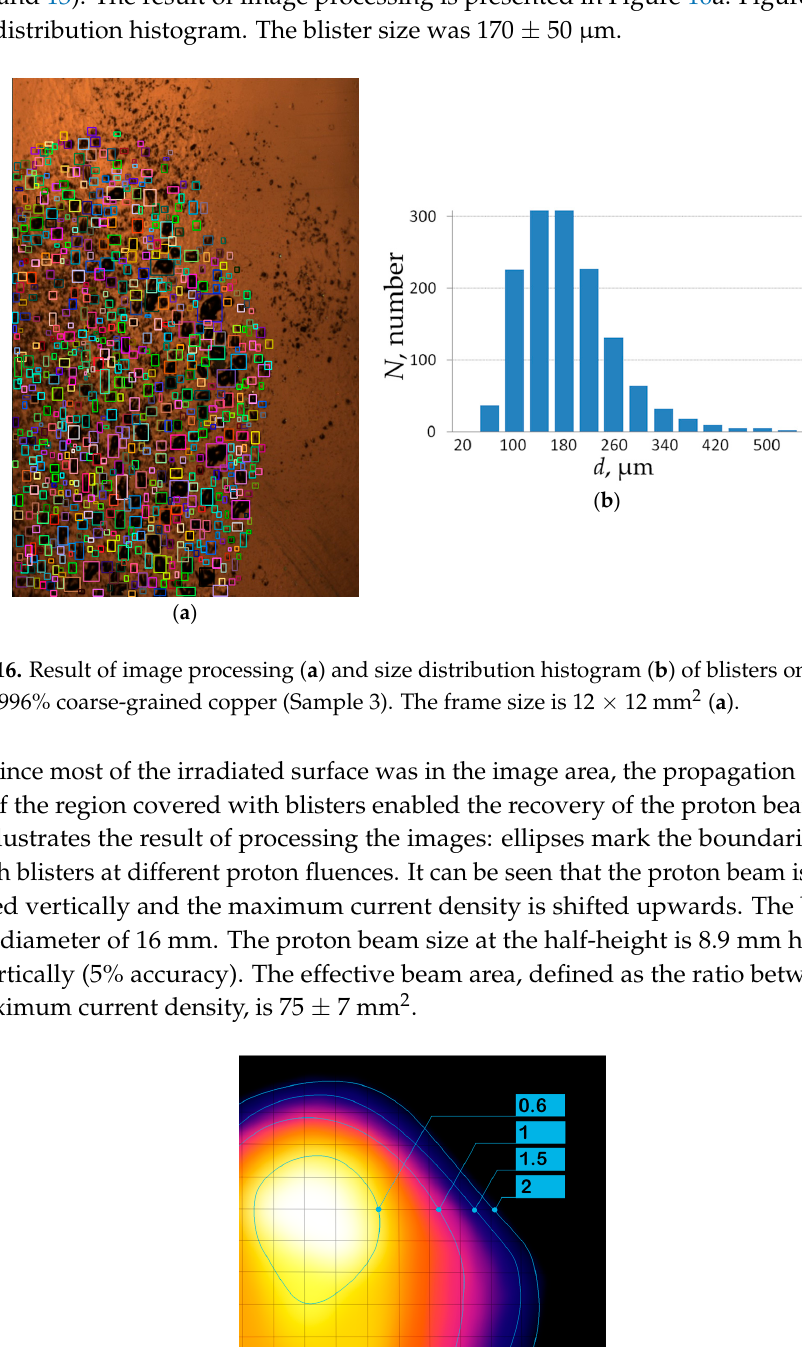
Figure 17. Boundaries of the region covered with blisters depending on the proton fluence (in 10 19 cm − 2 ). Grid step is 1 mm.